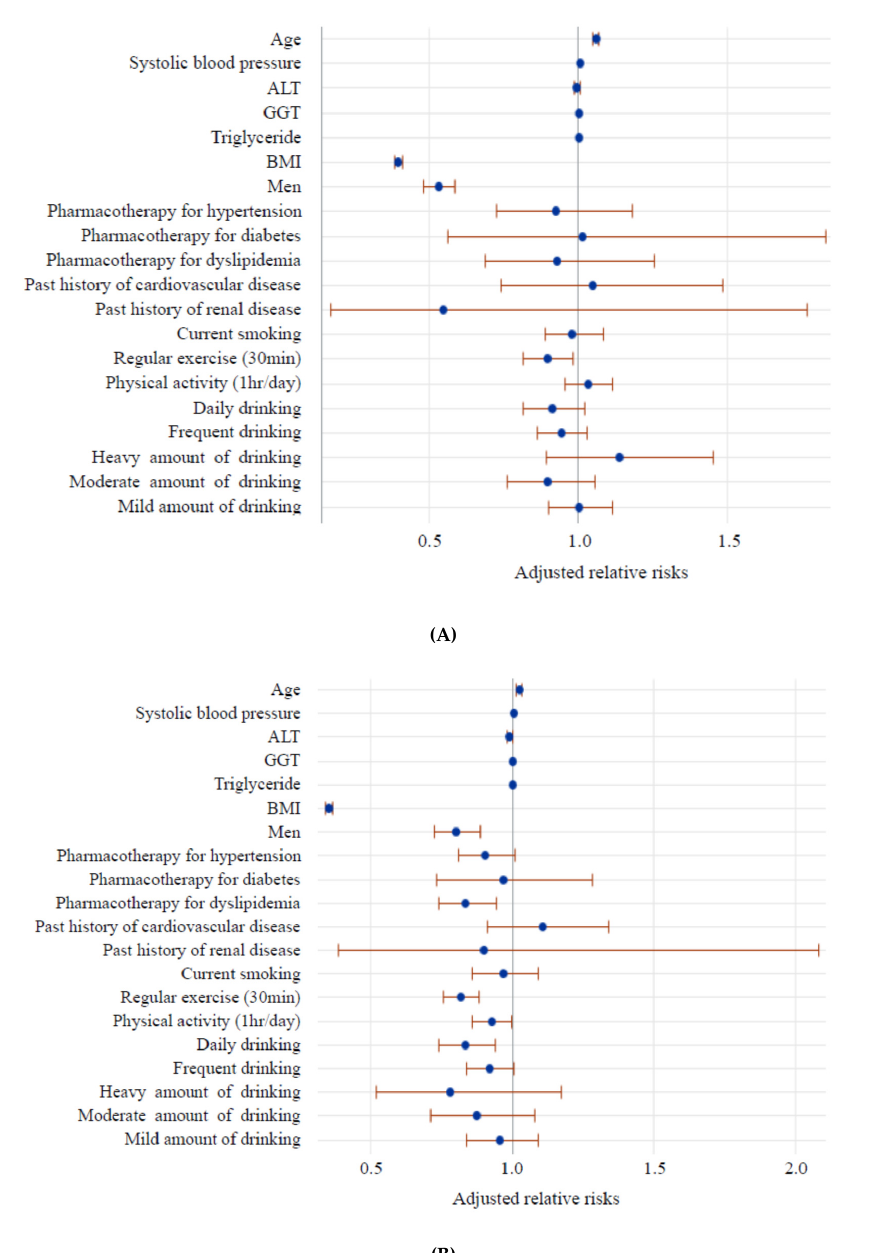
Figure 1. Adjusted relative risk of baseline factors for being underweight concomitant with weight loss after 6 years in younger (A) and older age groups (B). Each circle and horizontal bar represent Table 95. confidence interval after controlling for baseline confounders listed in the figure and baseline serum aspartate aminotransferase. Age, systolic blood pressure, alanine aminotransferase, GGT, triglyceride, and body mass index were treated as continuous variables. Dichotomized categories (pharmacotherapies for hypertension, diabetes, dyslipidemia, history of cardiovascular and/or renal disease, current smoking, regular exercise, physical activity) were evaluated vs. opposite corresponding conditions. Drinking every day and frequent drinking were evaluated vs. no drinking or hardly any drinking. Heavy ( ≥ 69 g ethanol), moderate (46–68 g ethanol), and mild (23–45 g ethanol) amounts of alcohol were evaluated vs. a lower amount of alcohol ( < 23 g